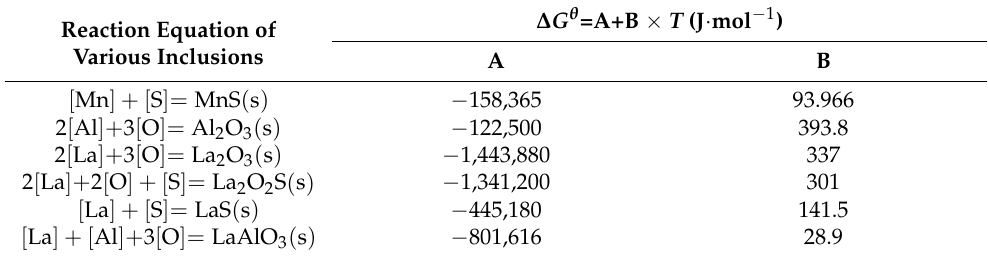
Table 2. The standard Gibbs free energy change for formation of various inclusions [34,35]. Reaction Equation